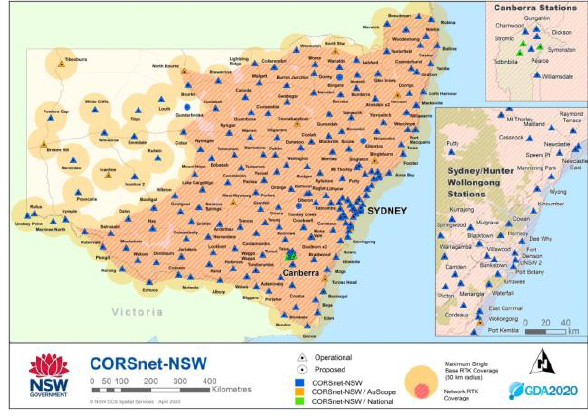
Figure 1 : CORSnet-NSW Coverage Map (NSW Government 2022a). Note orange single base